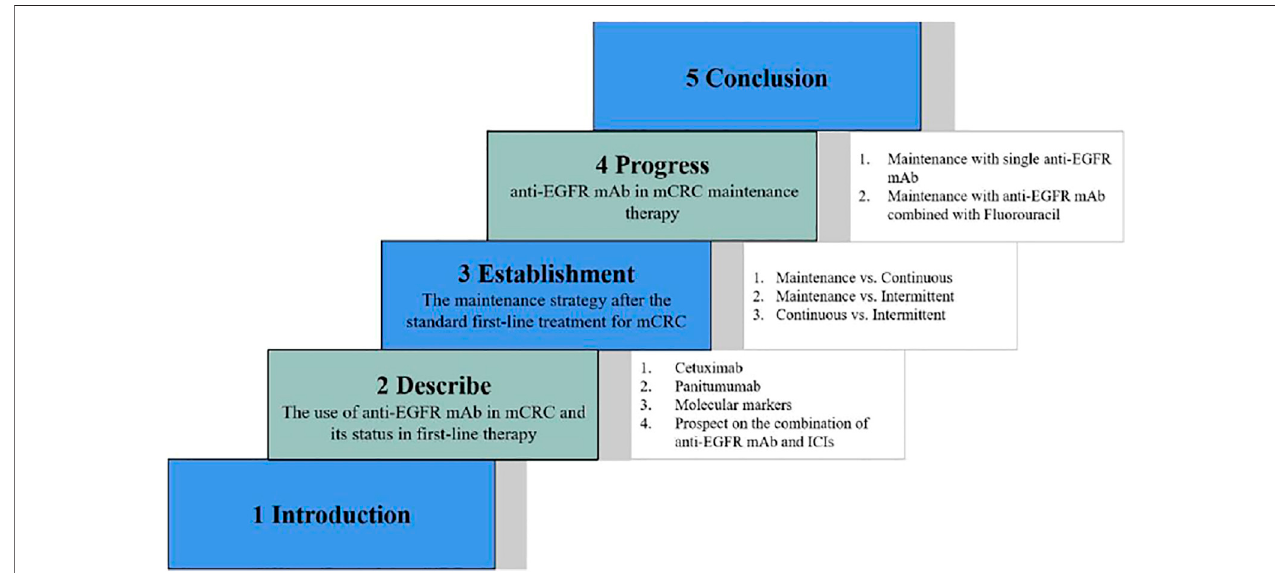
FIGURE1| Theschemeforthefulltext.Thestructureofthisarticleisshownwhichconsistsof fi veparts,includingintroduction,descriptionoftheuseofanti-EGFR mAbinmCRC aswellasitsstatusin fi rst-linetherapy,establishmentofthemaintenancestrategyafterthestandard fi rst-linetreatment formCRC,progressofanti-EGFR mAb in mCRC maintenance therapy, and